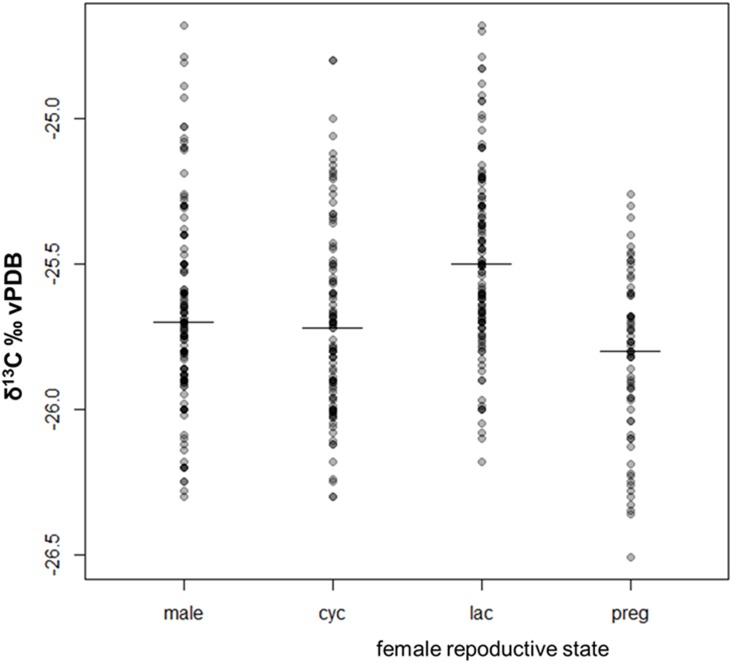
δ13C values and medians for bonobo males, cycling (cyc), lactating (lac) and pregnant females (preg).According to our model the differences between males and females with different reproductive statuses are significant in δ13C values, with the highest values in lactating females. This relationship could not be tested in the δ15N values given the significant interaction of sex/reproductive state with social dominance rank.